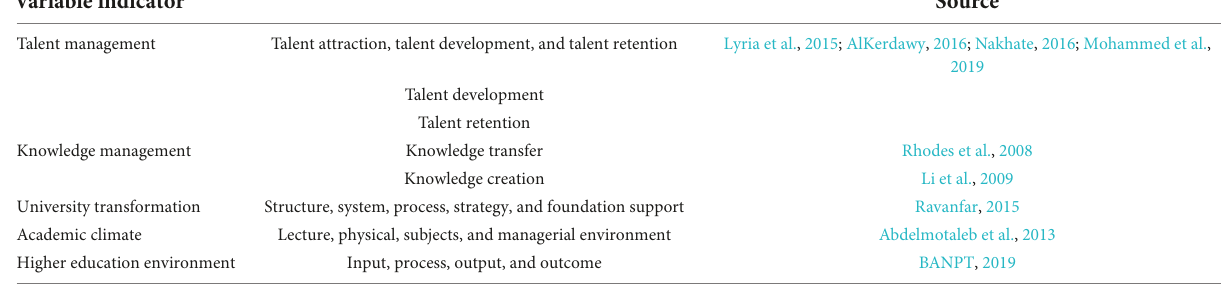
TABLE 3 Measurement